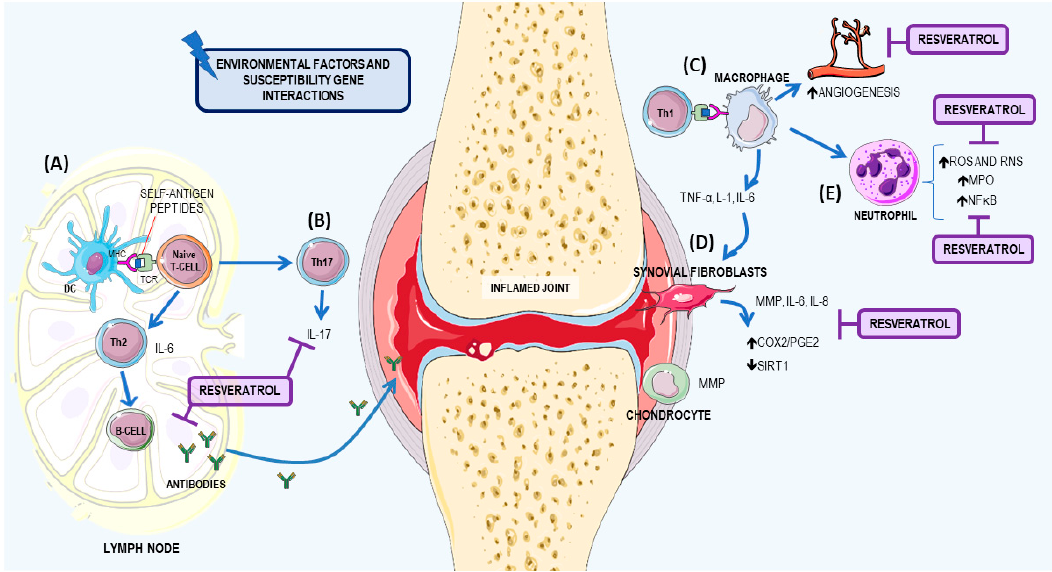
Figure 5. Rheumatoid arthritis mechanism and resveratrol’s role. The pathophysiological mechanism of rheumatoid arthritis (RA) is mediated by environmental factors and susceptible gene interactions, and the immune response involves a sequence of events. ( A ) In the lymph node, antigen recognition occurs by naïve T lymphocytes, which are differentiated to Th2 and Th17, with subsequent activation of B cells, with increased autoantibody production; ( B ) in addition, the Th17 response increases the pro-inflammatory cytokine, IL-17; ( C ) Synovial macrophages may stimulate angiogenesis, leukocyte and lymphocyte recruitment, fibroblast proliferation, and protease secretion, contributing to cartilage and bone destruction at the site of pannus formation. In addition, the increased cytokine production, especially TNF- α and IL-1, stimulates synoviocytes; ( D ) the synovial fibroblasts at the inflammatory site increase COX2/PGE2, and a decrease in SIRT1. Chondrocytes are also stimulated by synovial macrophages; ( E ) Macrophages increase the recruitment of neutrophils at the inflammatory site, by increasing the production of ROS and RNS and the activation of MPO and NF- κ B. Resveratrol is able to act by reducing the production of autoantibodies, Th17 population, oxidative stress and NF- κ B activation. Resveratrol also reduces COX2 and PGE2 expression and activates SIRT1, therefore improving the patient's clinical condition. COX2: cyclooxygenase 2; IL: interleukin; TNF- α : tumor necrosis factor alfa; MMP: metalloproteinases; MPO: myeloperoxidase; NF- κ B: nuclear factor kappa B; PGE2: prostaglandin E2; ROS: reactive oxygen species; RNS: reactive nitrogen species; SIRT1: sirtuin 1. This figure used elements from Servier Medical Art